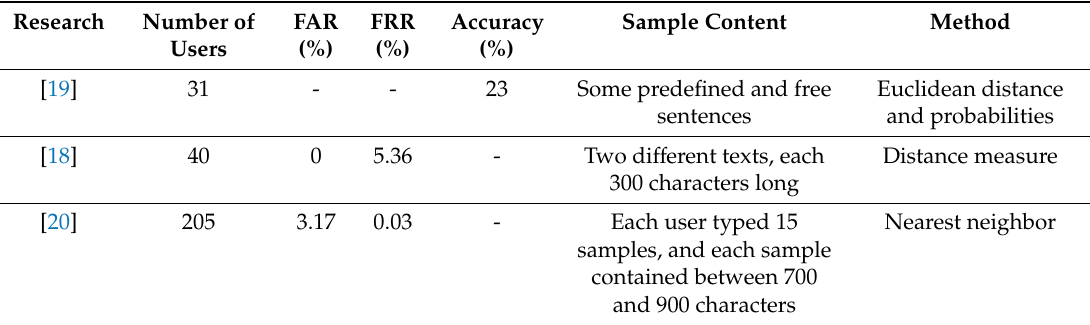
Table 2. Continuous authentication